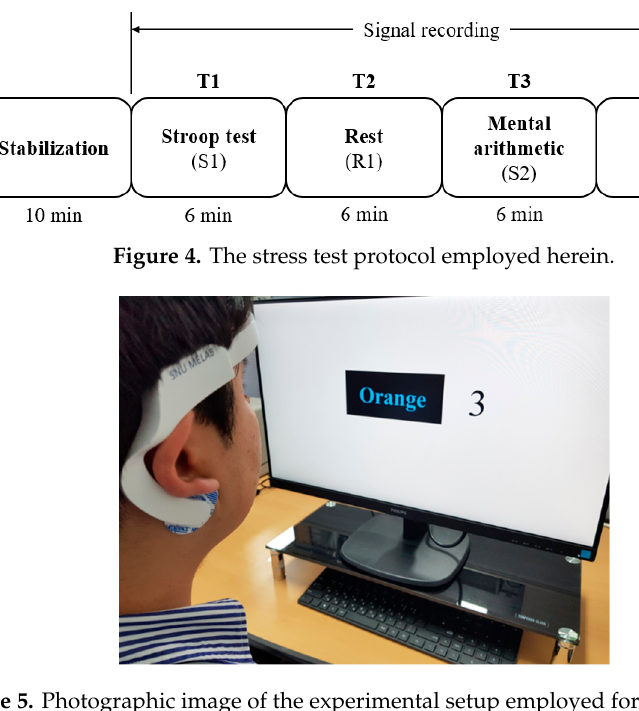
Figure 5. Photographic image of the experimental setup employed for the stress test.